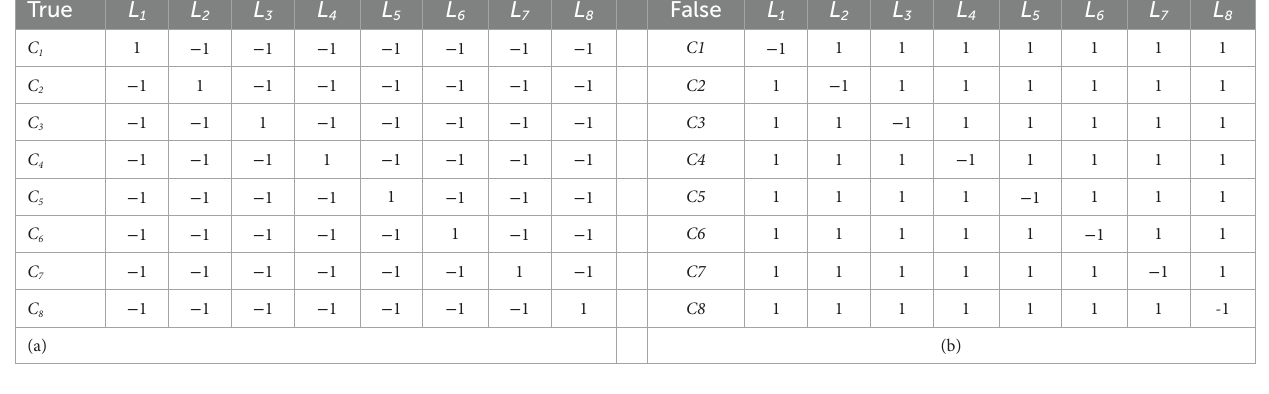
TABLE 2 Designed coding matrices for (a) multi-SVM true and (b) false learners. Where learner li is directed to deal with class cj as corresponding assigned values.